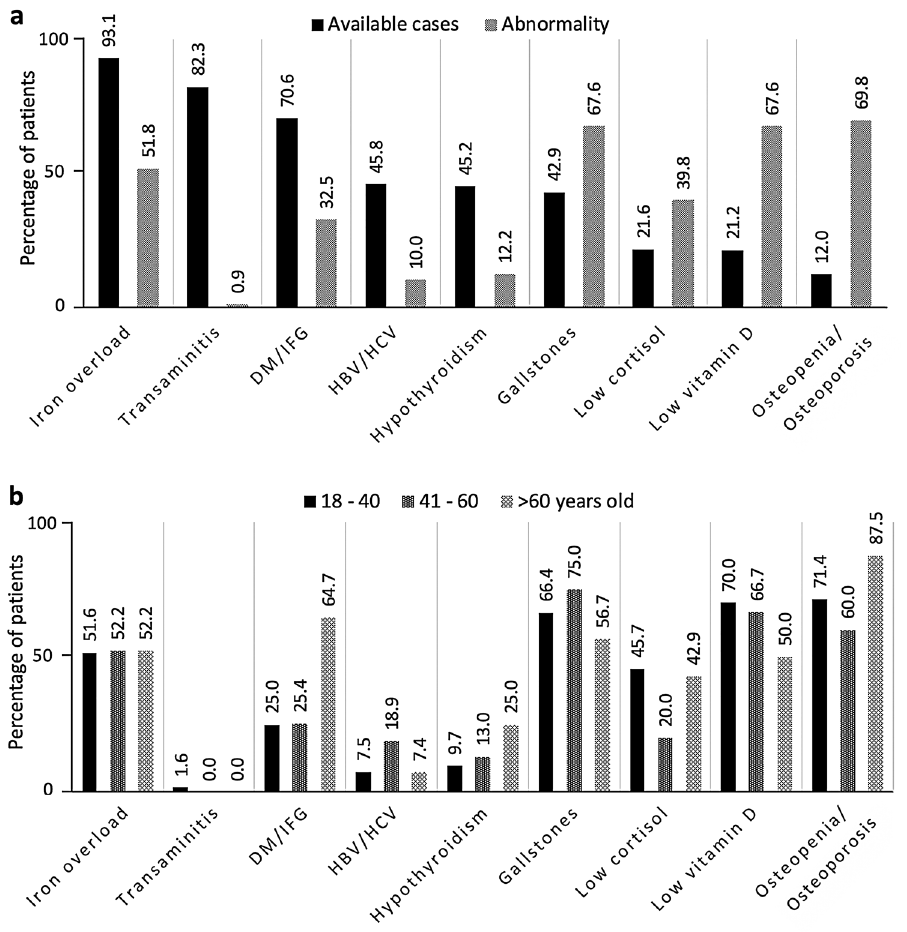
Figure 1. Complication of thalassemia patients throughout a study period (2012–2017). ( a ) Percentage of available patients that have been tested and those that have been diagnosed for each complication. ( b ) Rates of patients with each complication by age